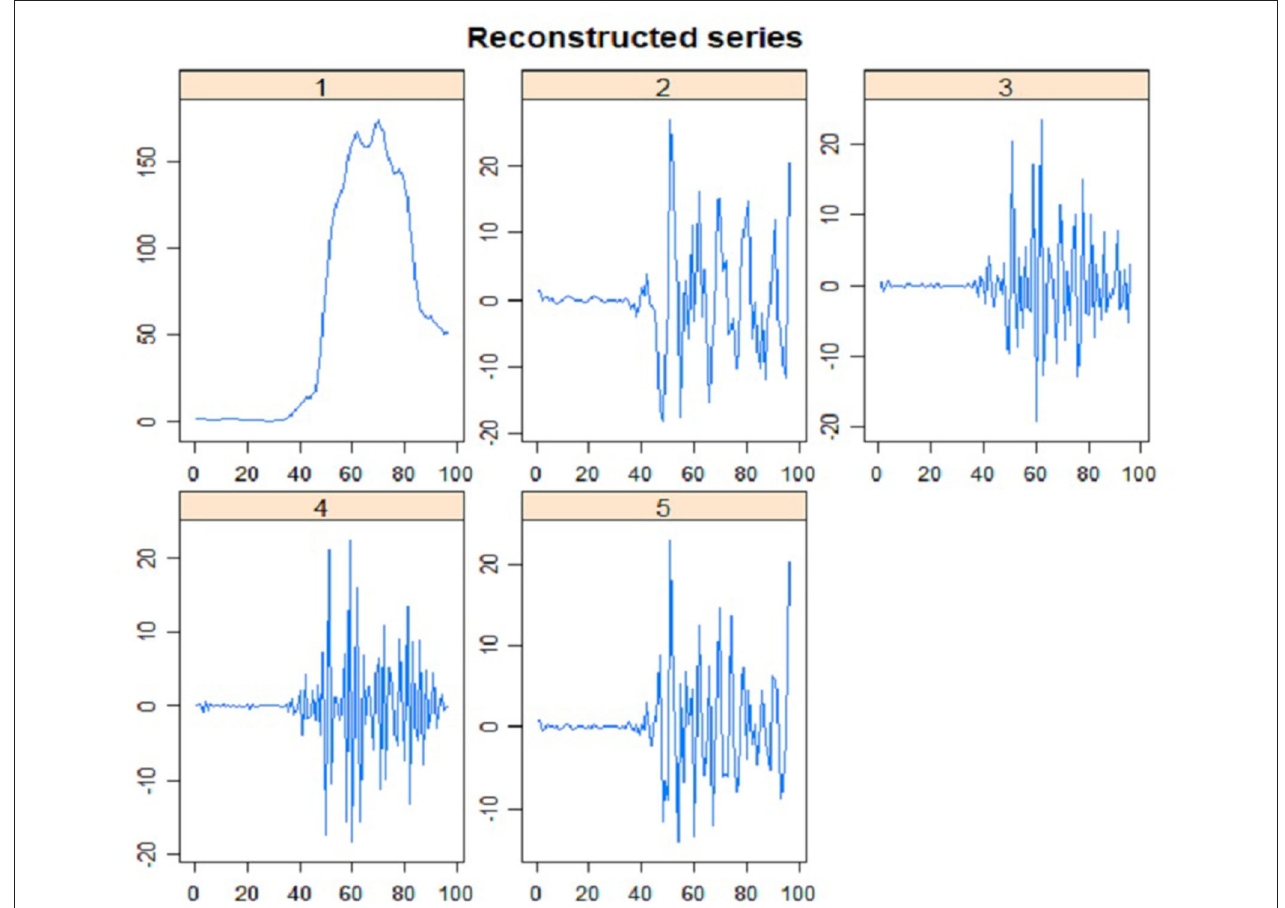
FIGURE 7 | First stage: Elementary Reconstructed Series (L